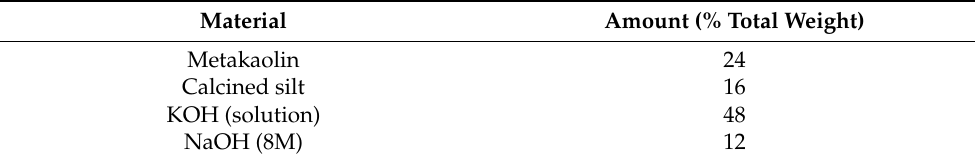
Table 3. Geopolymer-based grout mix design.